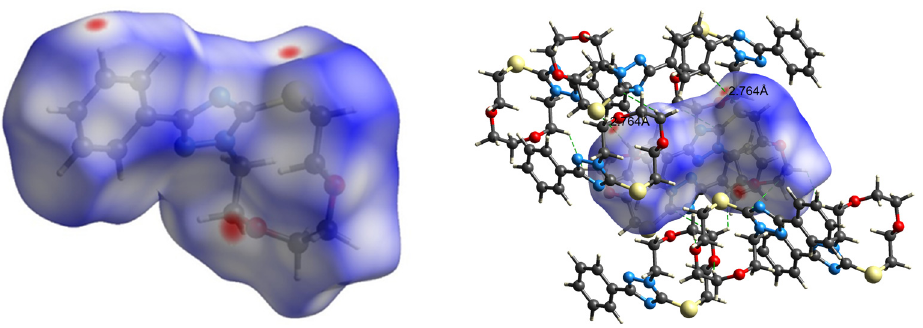
Figure 8. d norm mapped on the Hirshfeld surface for visualizing the intermolecular hydrogen bonding interactions in 3 .